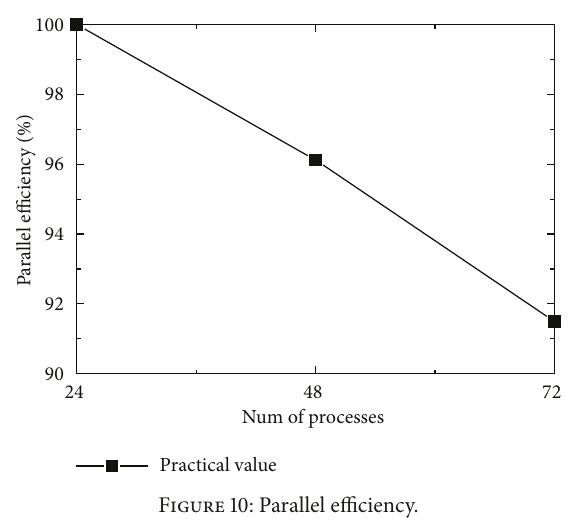
the black line, red dash, and blue dot represent the results of 24 processes, 48 processes, and 72 processes, respectively. The Mie solution is consistent with the numerical